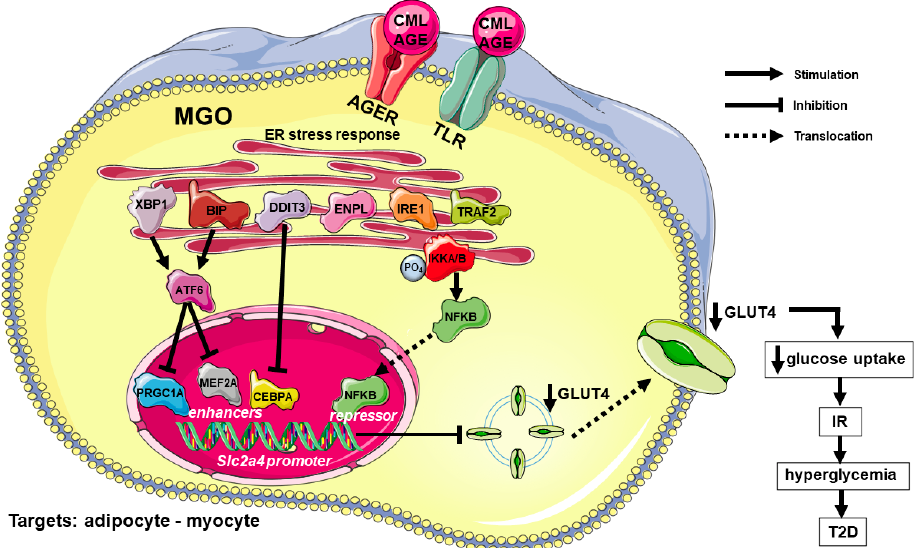
Figure 1. Advanced glycation end products (AGE)-induced regulation of glycemic homeostasis and glycemic homeostasis: participation of inflammatory and endoplasmic reticulum stress. In adipose and muscle tissues, AGE/CML binding to AGER and TLR activate the ER-stress response, including increased expression and/or activation of BIP, ENPL, XBP1, DDIT3, IRE1 and TRAF2. XBP1 and BIP activate ATF6, which is a repressor of the transcription factor PRGC1A and MEF2A (enhancers of Slc2a4 gene), thus decreasing Slc2a4 expression. On the other, IRE1/TRAF2 activation overlap the inflammatory pathway phosphorylating IKKA/B, and promoting NFKB dissociation and migration into the nucleus, where it plays a potent repressor effect upon Slc2a4 gene expression. Besides, intracellular MGO can contribute to the increase in the activity of proinflammatory cytokines, reinforcing this pathway. These effects on the Slc2a4 gene expression decreases GLUT4 synthesis and plasma membrane content, eventually decreasing insulin-induced glucose uptake, and establishing IR. In turn, IR leads to hyperglycemia, which can cause T2D or worsen preexisting DM. Symbols are: AGE, advanced glycated end product; AGER, advanced glycation end product-specific receptor, alias RAGE; ATF6, cyclic AMP-dependent transcription factor ATF; BIP, endoplasmic reticulum chaperone BIP, alias GRP78; CEBPA, CCAAT enhancer binding protein alpha; CML, carboxymethyl-lysine; DM, diabetes mellitus; DDIT3, DNA damage-inducible transcript 3 protein, alias CHOP10/GADD153; DM, diabetes mellitus; ENPL, endoplasmin, alias GRP94; ER, endoplasmic reticulum; GLUT4, solute carrier family 2, facilitated glucose transporter member 4; IKKA/B, inhibitor of nuclear factor kappa-B kinase subunits alpha/beta; IR, insulin resistance; IRE1, inositol requiring enzyme-1; MGO, methylglyoxal; MEF2A, myocyte enhancer factor 2A; NFKB, nuclear factor NF-kappa-B; PRGC1A, peroxisome proliferator-activated receptor gamma coactivator 1-alpha, alias PGC1A; Slc2a4, solute carrier family 2 member 4 gene; T2D, type 2 diabetes mellitus; TLR, toll-like receptors; TRAF2, TNF receptor-associated factor 2; XBP1, X-box-binding protein 1. Names and symbols of proteins are in accordance with the UNIPROT database (https://www.uniprot.org/, accessed on 2 November 2021). Parts of the figure were drawn from Servier Medical Art (https://smart.servier.com/, accessed